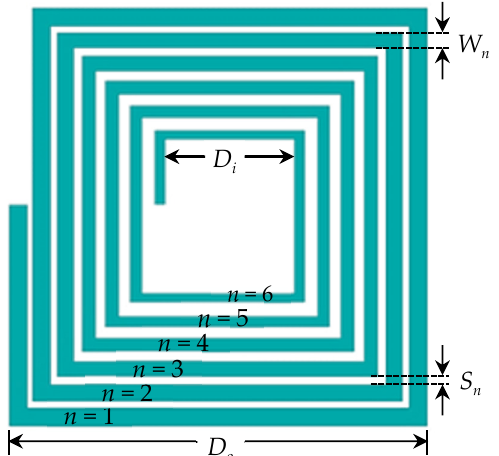
Figure 1. A modified spiral inductor design with variable metal line width.